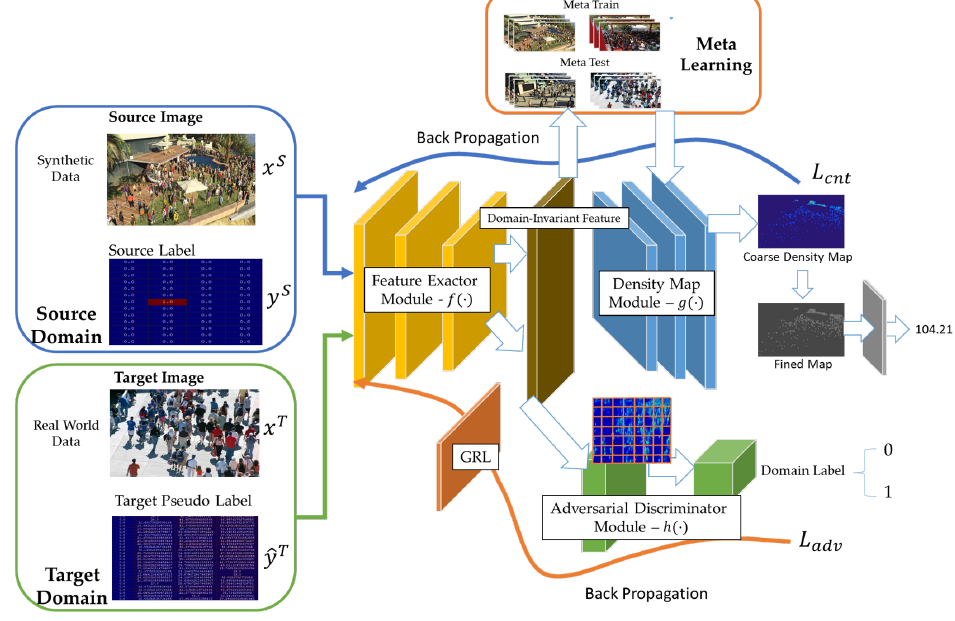
Figure 3. The domain invariant feature representation module framework, which allows models to extract domain-invariant features, to reduce the impact of domain gaps between the source and target